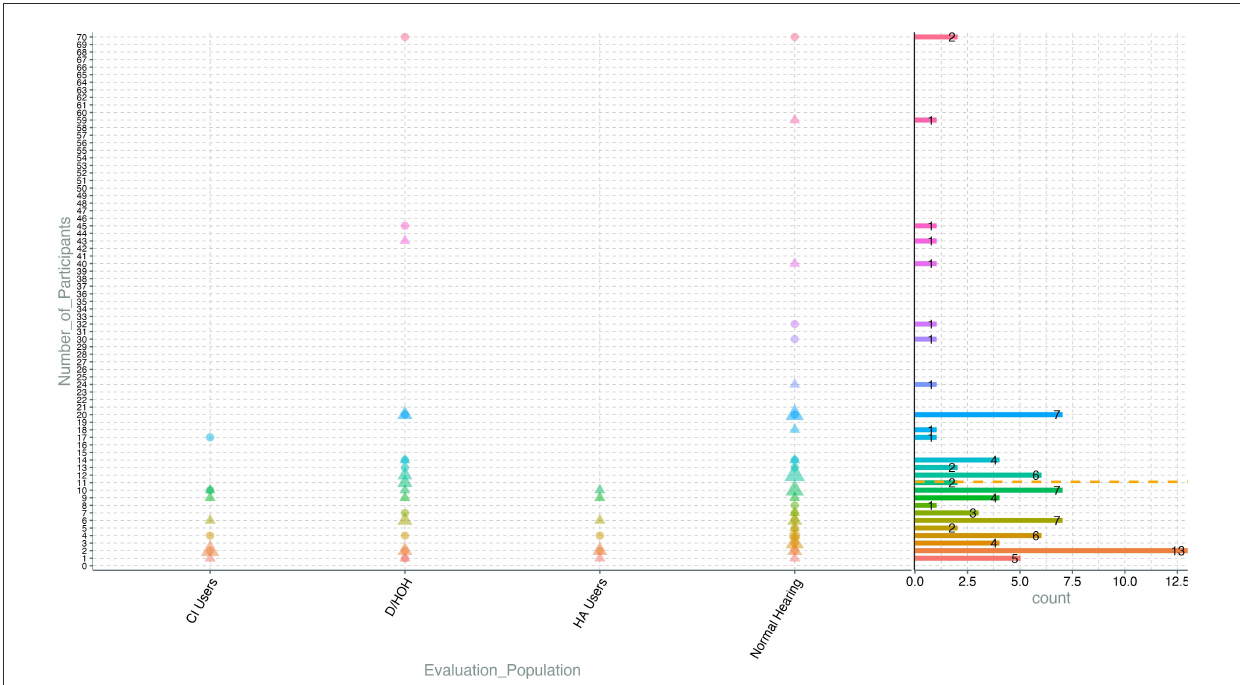
FIGURE9 Distribution of the number of participants for each of the populations evaluated; a triangle indicate a wearable device, a circle indicates a fixed device and the size of the shape represents the amount of similar devices. D/HOH represents persons suffering from a hearing disability, but without any hearing assistive device. The dashed orange line represents the mean.